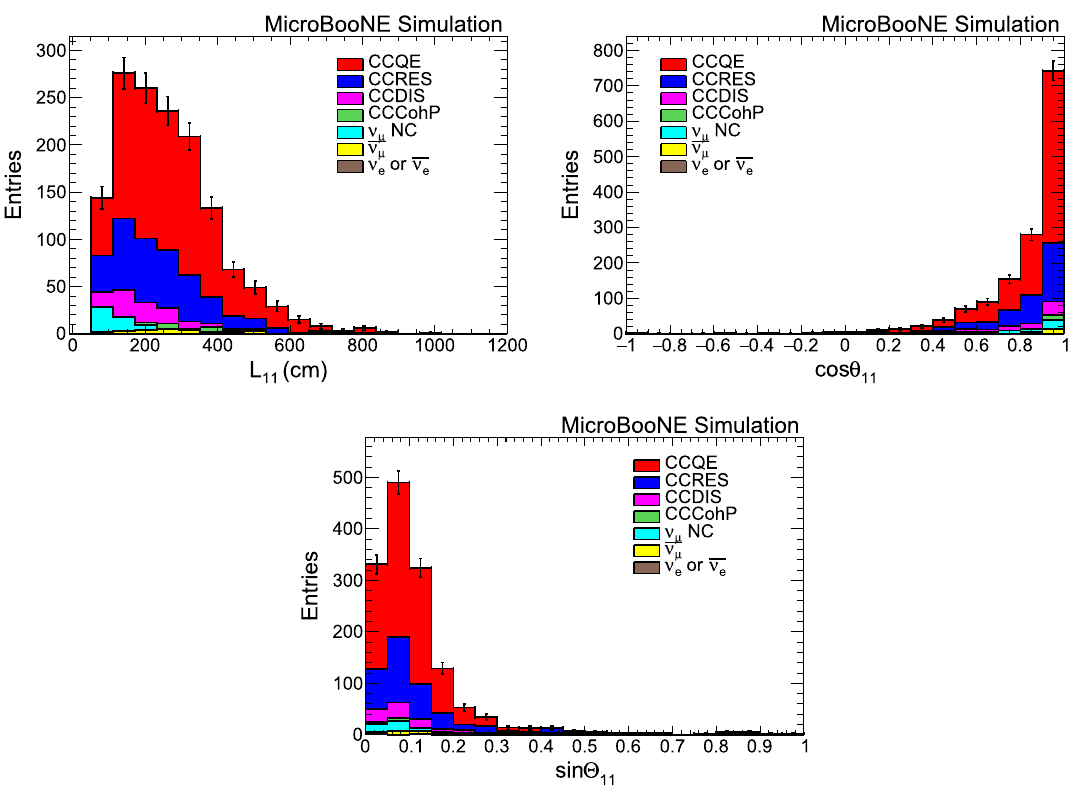
Fig. 29 Multiplicity = 1 GENIE default predictions for candidate muon track length, cos θ , and sin (cid:17) distributions. Black error bars represent MC statistical uncertainties